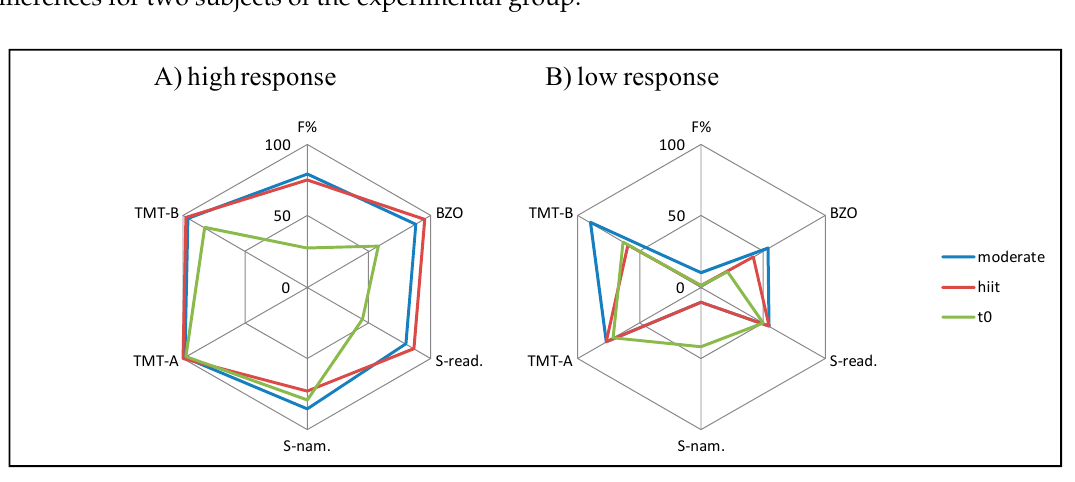
Figure 7. Cognitive performance (percentile rank) for baseline and after each intensity. Exemplary for a high cognitive performer ( A ) and a low cognitive performer ( B ) of the experimental group. Cognitive test variables including d2-R (F%, BZO), Stroop task reading condition (S-read.) and naming condition (S-nam.) and TMT (TMT-A, TMT-B). Green line: t0 (baseline), blue line: moderate condition, red line: hiit condition. The higher the net the higher the cognitive performance.